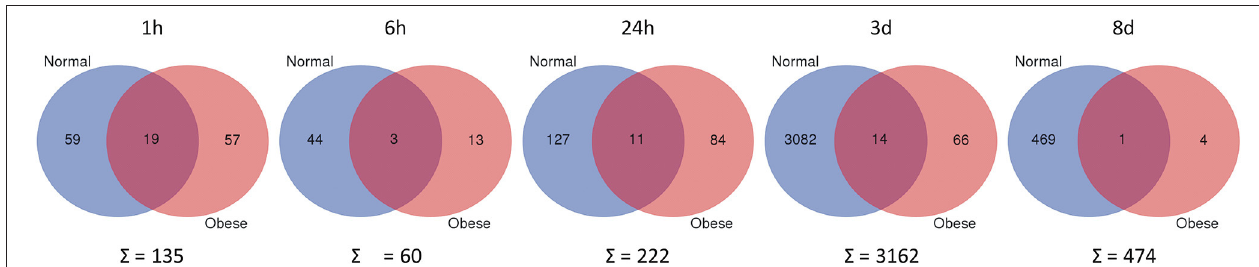
Frontiers in Physiology |